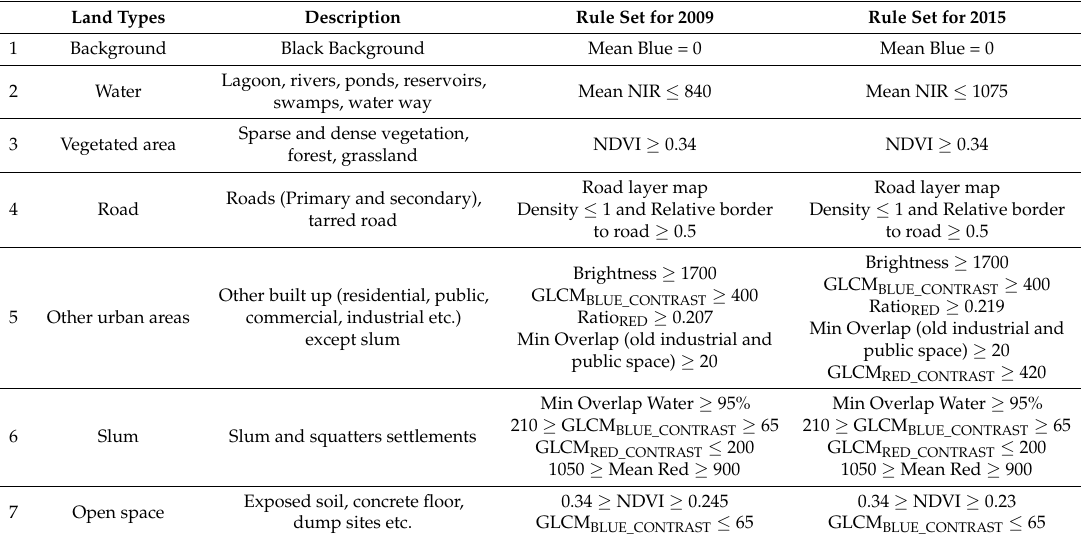
Table 4. Description of land use classes and a summary of rule set used for the classification in